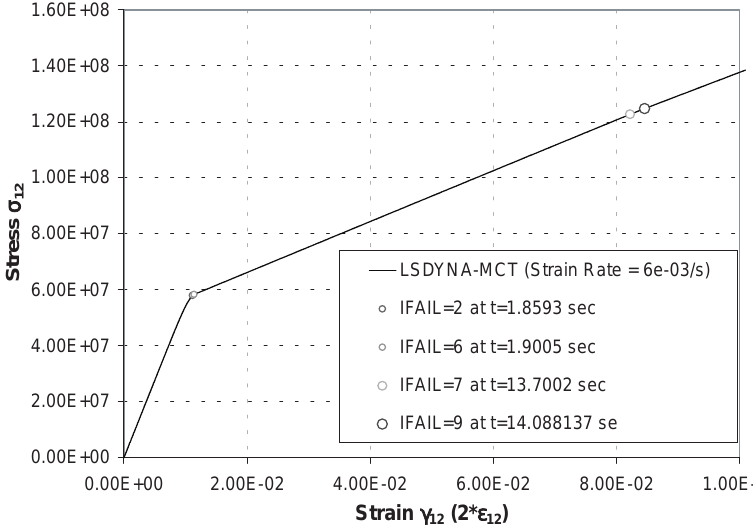
Fig. 4. σ 12 − γ 12 response prediction of a plain weave woven fabric composite subjected to in-plane shear with the strain rate of 6e-03/s.